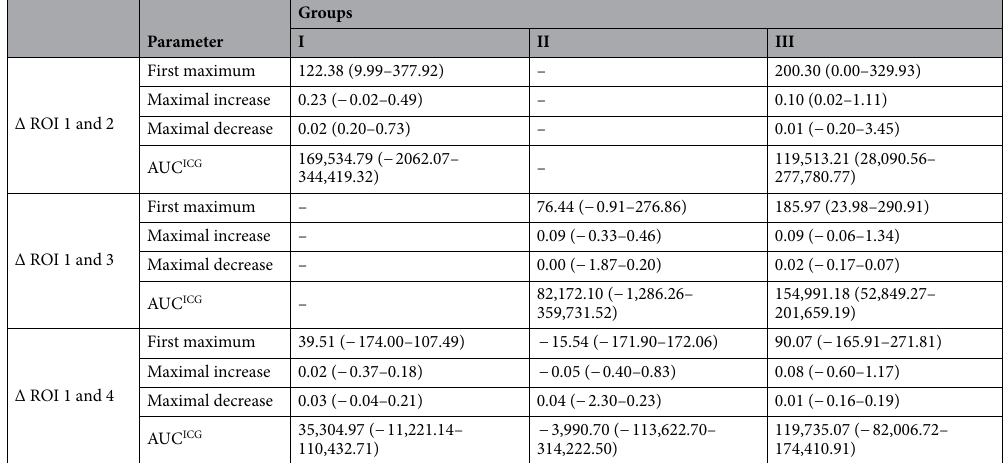
The comparison of registered corresponding ICG values of each ROI (2, 3, and 4) between groups I–III showed a significant difference for first maximum ( p < 0.01), maximal increase ( p = 0.02), and AUC ICG ( p < 0.01) within the corresponding ROI 2 between groups I and III. A comparison of registered ICG values within